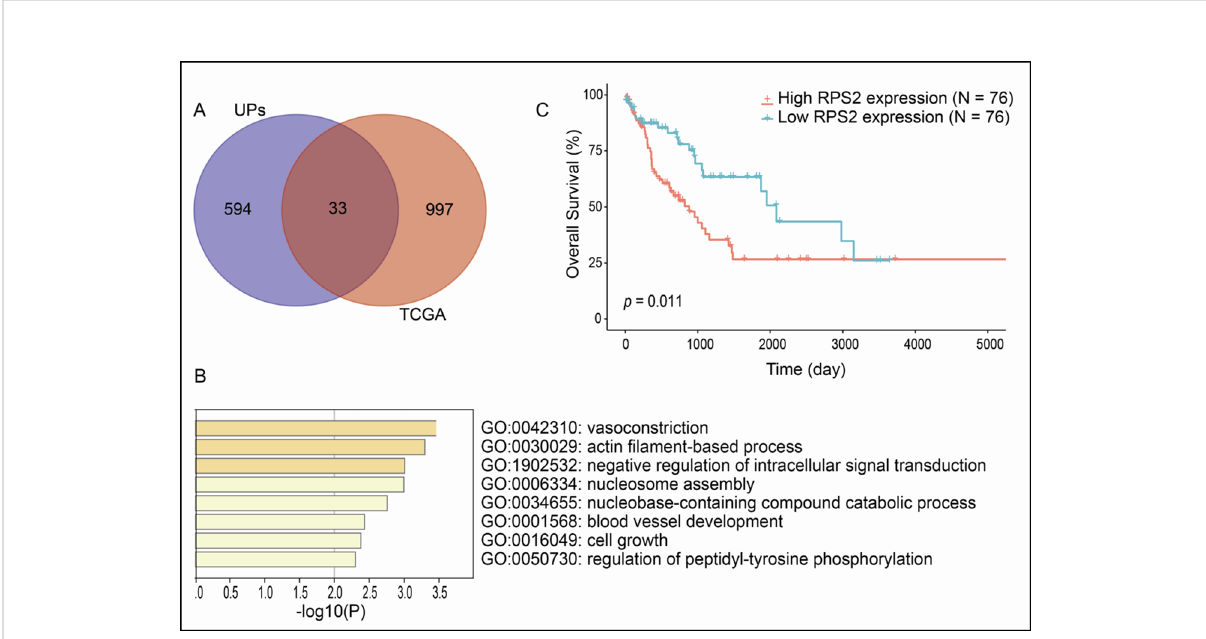
FIGURE 4 Overall survival-related UPs identi fi ed with overlapping analysis between 627 UPs and survival-related genes derived from TCGA database. (A) Venn diagram showed 33 molecules were associated with prognosis. (B) The biological processes involved in these prognostic related molecules. (C) Overall survival curve of